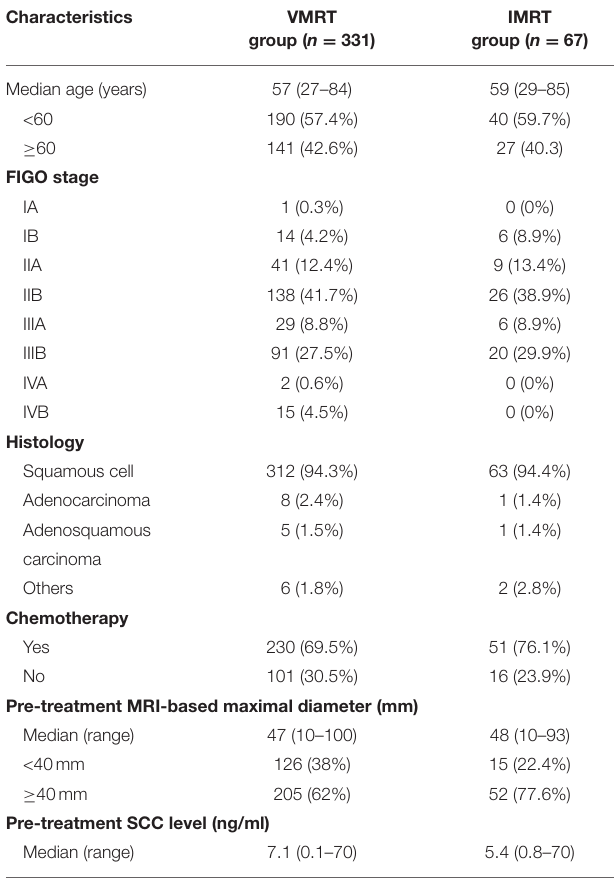
FIGO, International Federation of Gynecologic Oncology; SCC, squamous-cell carcinoma antigen.